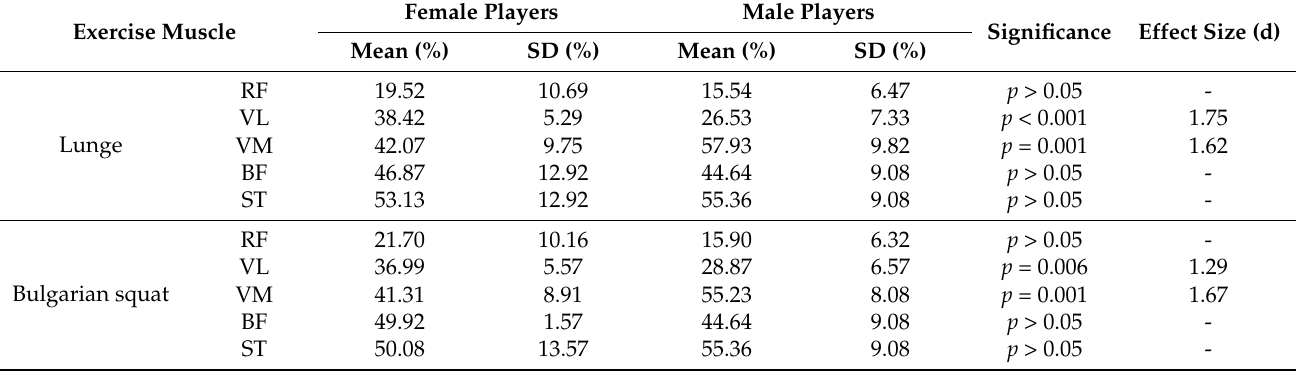
Figure 3. Intragroup muscular pattern (mean ± SD) in percentage. The intragroup muscular pat- tern expresses the activation of each muscle belly in relation to the total muscle (quadriceps and hamstrings). The asterisk (*) shows that there is a significant difference. Table 3. Intragroup muscular pattern in percentage.